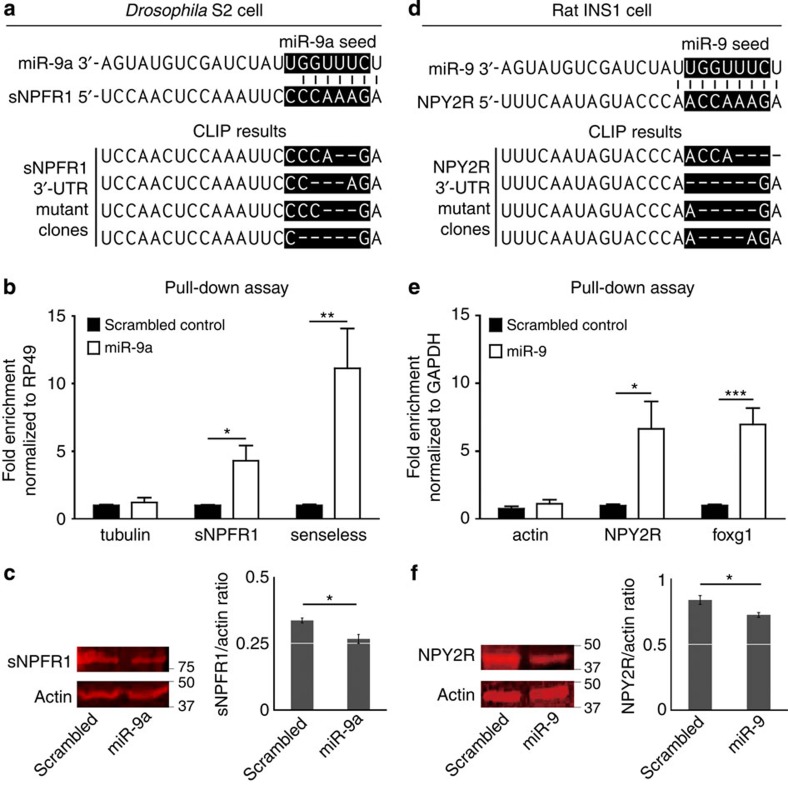
miR-9a
regulates the insulin modulator
sNPFR1
and its mammalian orthologue
NPY2R.(a,d; above) Alignment of the mature miR-9a sequence with its predicted target sequences in the 3′-UTRs of sNPFR1 and NPY2R. (a,d; below) Mutant sNPFR1 and NPY2R 3′-UTR clones induced in CLIP assays in Drosophila S2 and rat INS-1 cells, respectively. (b,e) miRNA–mRNA–RISC pull-down assays in Drosophila S2 (b) and rat INS-1 (e) cells reveal clear binding of miR-9a to both the sNPFR1 and NPY2R mRNAs. Transfection of miR-9a leads to enrichment of sNPFR1 and NPY2R mRNAs just like known target mRNAs senseless and foxg1 when normalized to rp49 and GAPDH levels. Transfection with a scrambled version of miR-9a (Supplementary Table 3) causes no such enrichment. (c,f) Transfection of a synthetic miR-9a duplex reduces the level of sNPFR1 protein produced by S2 cells (c) and the level of NPY2R protein produced by INS-1 cells (f) when compared with levels produced on transfection with a scrambled miR-9a (Supplementary Table 3). Data in b,c and e,f are presented as mean±s.e.m. from at least three independent experiments. Statistical significance was assessed by two-tailed Student's t-test, *P<0.05, **P<0.01, ***P<0.001.